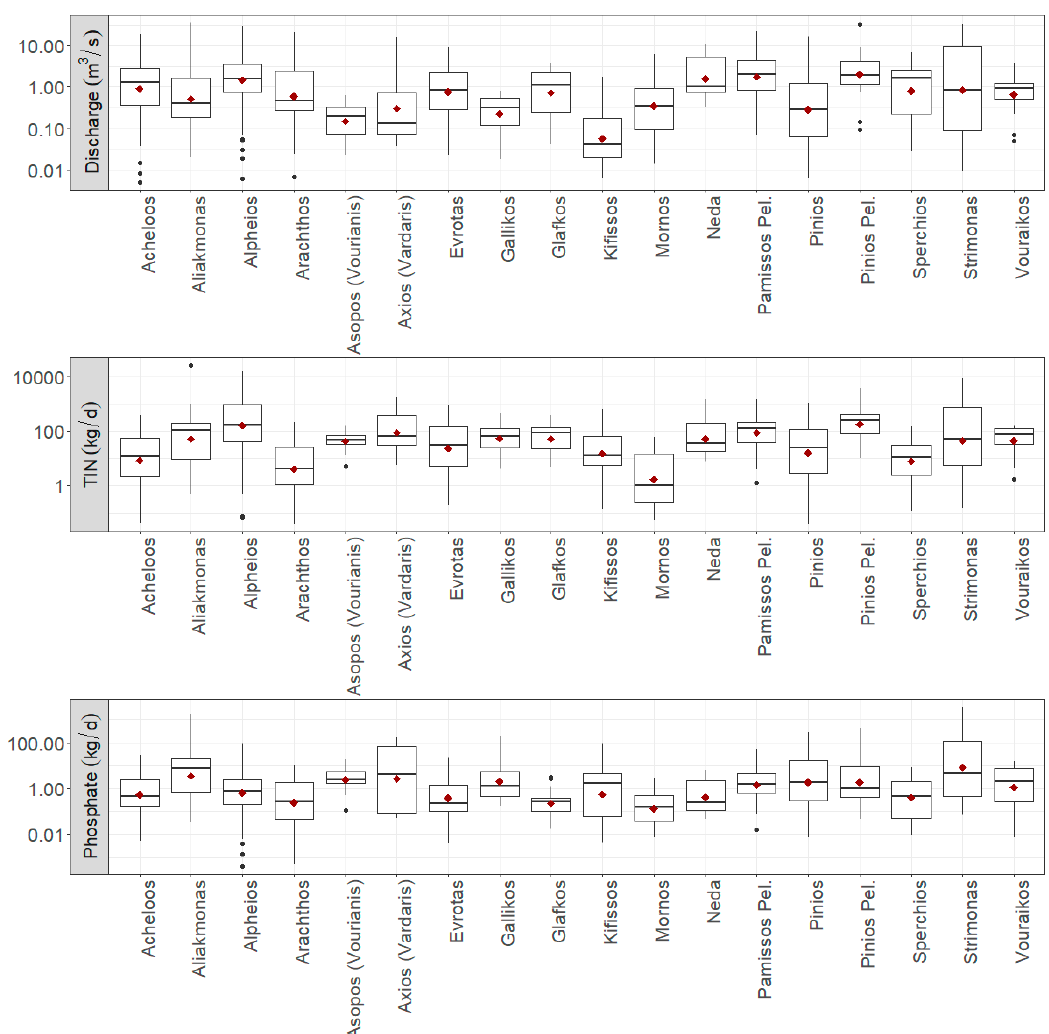
Figure 2. Boxplots of discharge (log. scaled), total inorganic nitrogen load (log. scaled) and inorganic phosphorus load (log. scaled) per river. The red dot indicates the mean value.